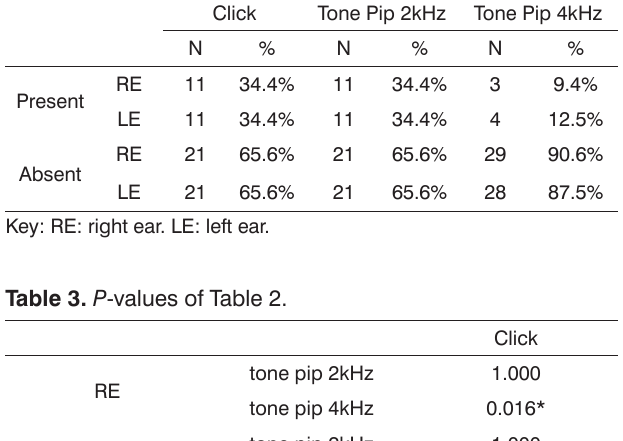
Significance: p < 0.05 Key: RE: right ear. LE: left